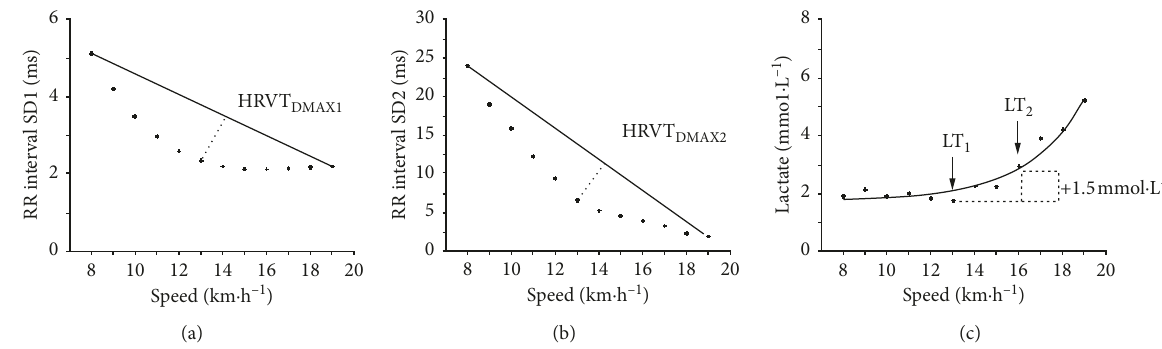
Figure 1: The HRVT DMAX1 (a) and HRVT DMAX2 (b) thresholds determined by the Dmax method and LT 1 and LT 2 (c) determined by lactate concentrations. Table 1: Aerobic and anaerobic thresholds expressed as absolute and relative (mean ± SD) values for speed, blood lactate concentrations,